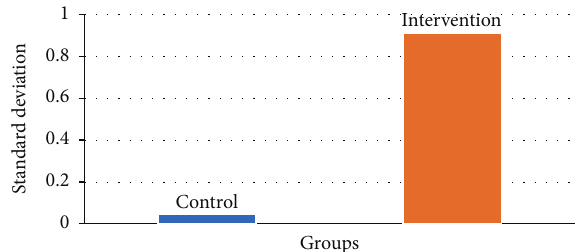
Figure 1: Change in the WAZ from discharge after first-stage palli- ation until admission for second-stage palliation.